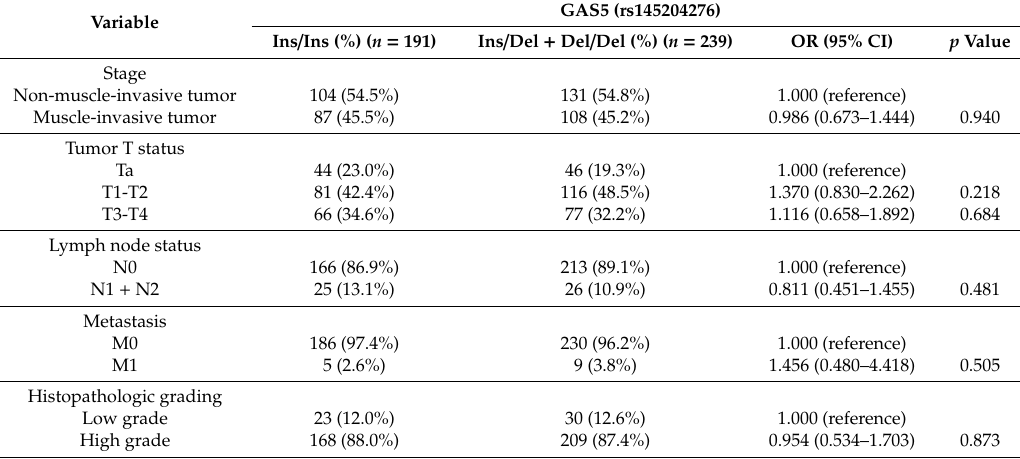
Table 3. Distribution frequency of the clinical status and growth arrest-specific 5 (GAS5) rs145204276 genotype frequencies in 430 UCC patients.